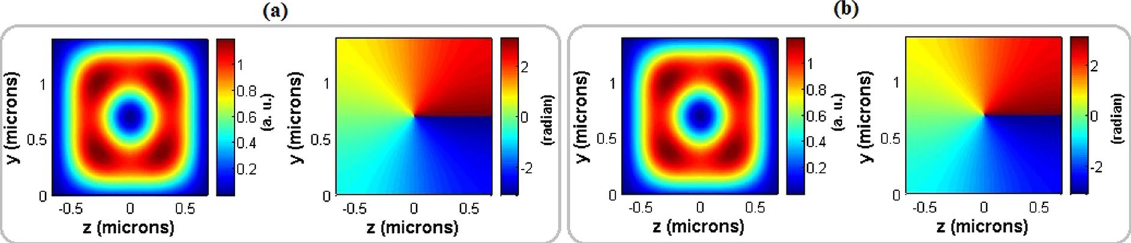
Figure 4. Power distribution (left) and phase pattern (right) of the input ( a ) and output ( b ) horizontally polarized optical modes in the polarization converter part of the modulator without applying external electric field.